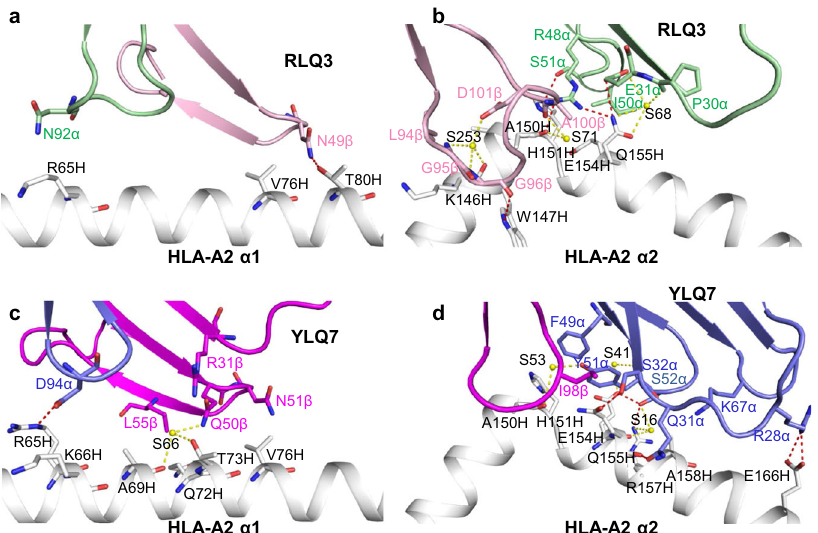
Fig. 5 Interactions of TCRs with HLA-A2. a Interactions between RLQ3 and the HLA-A2 α 1 helix. The side chains of contacting residues are drawn in stick representation with carbon atoms in green (TCR α chain), pink (TCR β chain) or gray (HLA-A2), nitrogen atoms in blue, and oxygen atoms in red. Hydrogen bonds are indicated by red dashed lines, water molecules are shown as yellow spheres, and water-mediated hydrogen bonds are indicated by yellow dashed lines. b Interactions between RLQ3 and the HLA-A2 α 2 helix. c Interactions between YLQ7 and the HLA-A2 α 1 helix. TCR α chain, blue; TCR β chain, magenta. d Interactions between YLQ7 and the HLA-A2 α 2 helix. CDR3 β loop fi ts snugly in a notch between the C-terminus of RLQ and the N-terminus of the HLA-A2 α 2 helix. The principal focus chain of P6 Gln inserts into a pocket formed by CDR3 α residues Phe91, Gln93, Gly95, and Gln96 (Fig. 6e). Also important for recognition is P8 Tyr, whose side chain packs tightly against that bonds with CDR3 β Gly96 (Fig. 6a). Computational alanine NATURE COMMUNICATIONS| (2022) 13:19